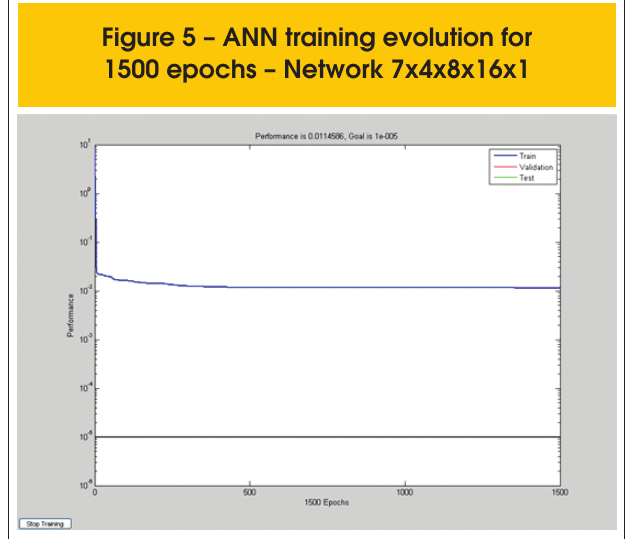
Figure 5 – ANN training evolution for 1500 epochs – Network 7x4x8x16x1